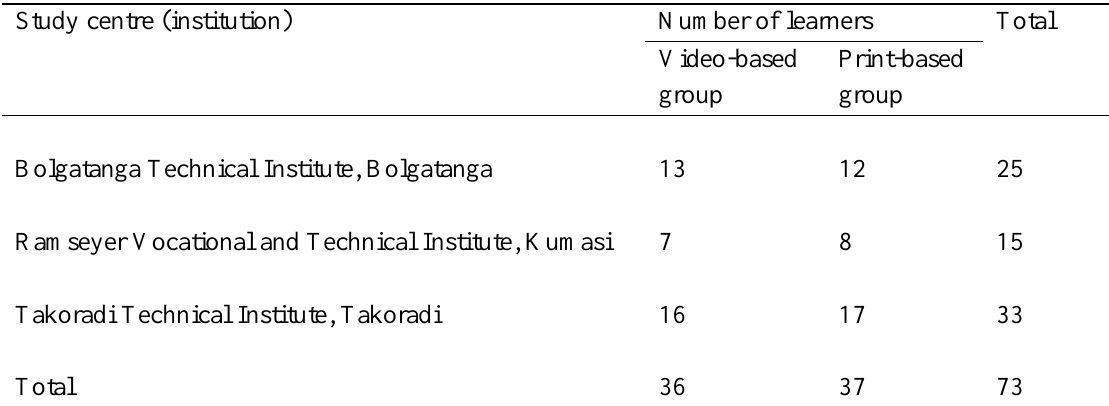
Distribution of Study Sample according to Experimental Conditions Study centre (institution) Number of learners Total